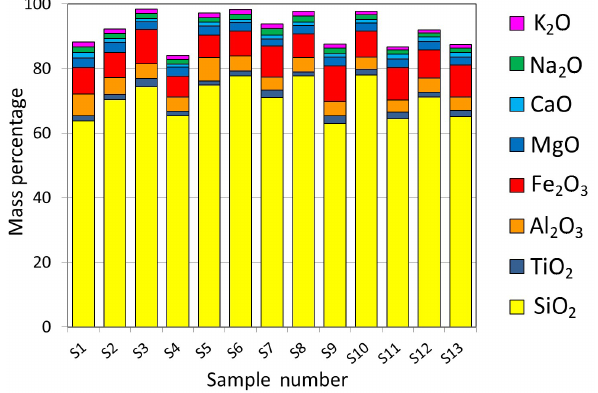
Figure 4. Compositional plot showing major oxide percentages by mass from ICP-OES analysis of < 38µm sieved soils.